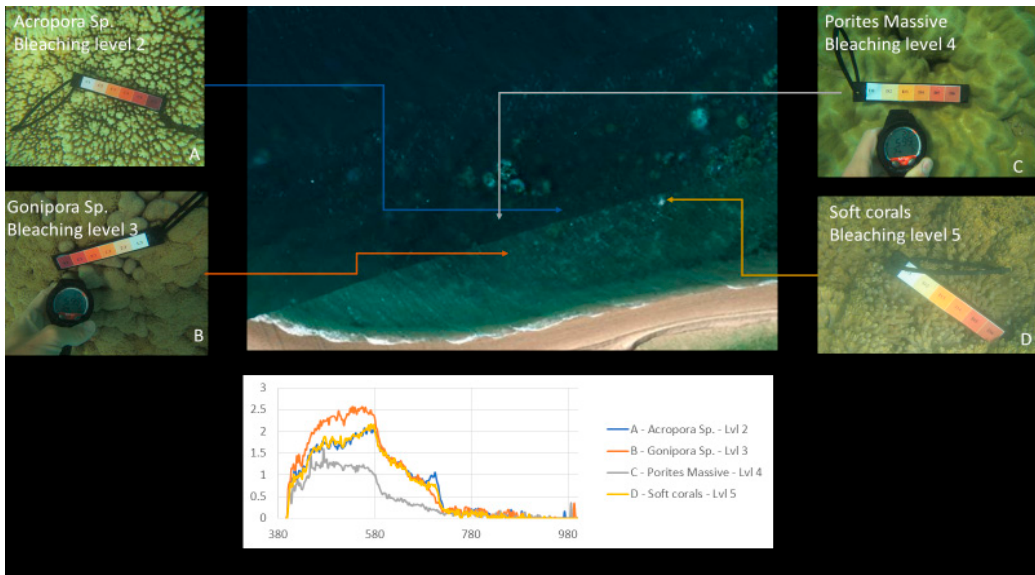
Figure 18. Example of spectral response “fingerprints” of bleaching levels 2, 3, 4 and 5 for Acropora , Gonipora , Porites massive and soft corals, respectively, for spectral comparison.